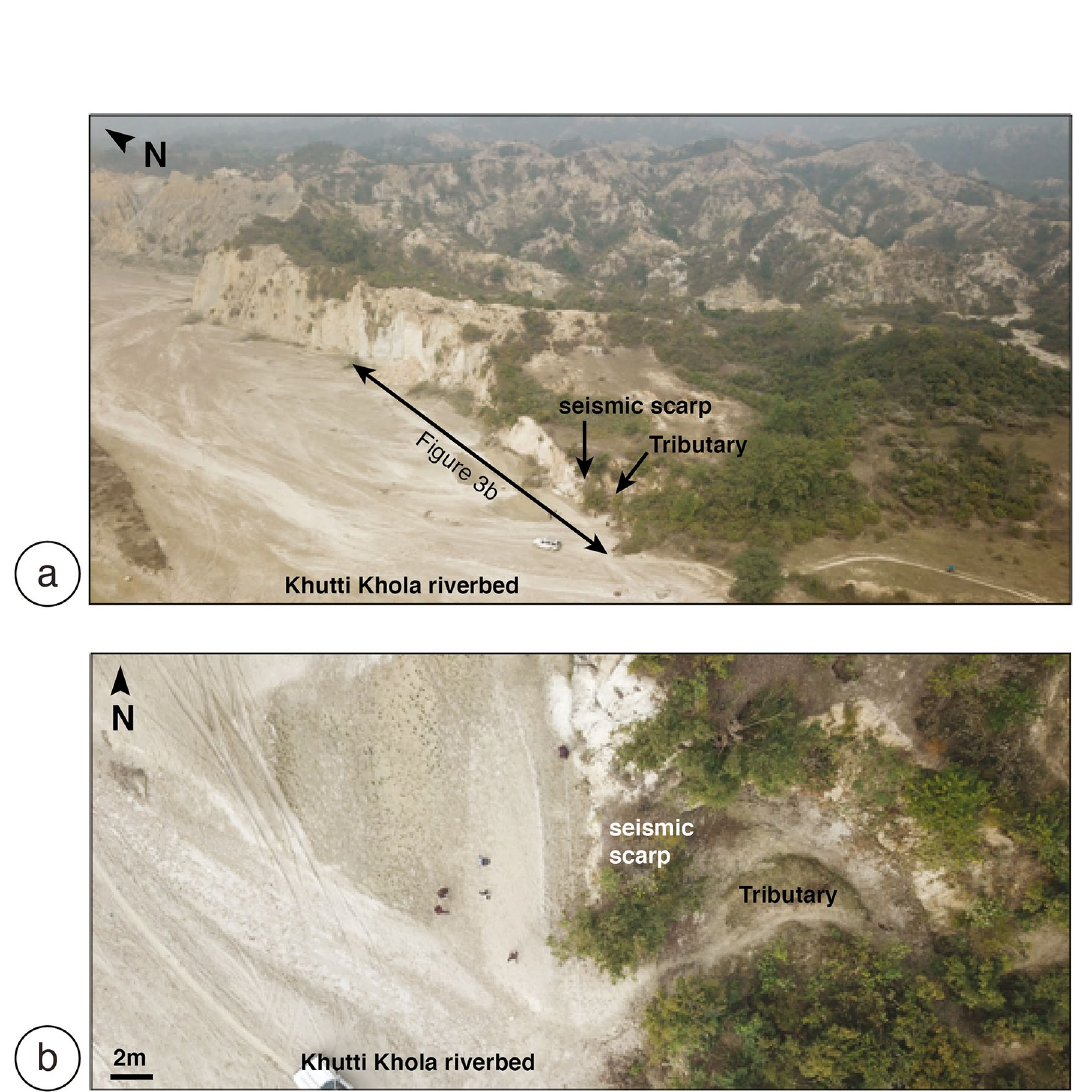
Figure 3. ( a ) Perspective view of the Khutti khola site locating the rivercut section Fig. 4b, ( b ) map